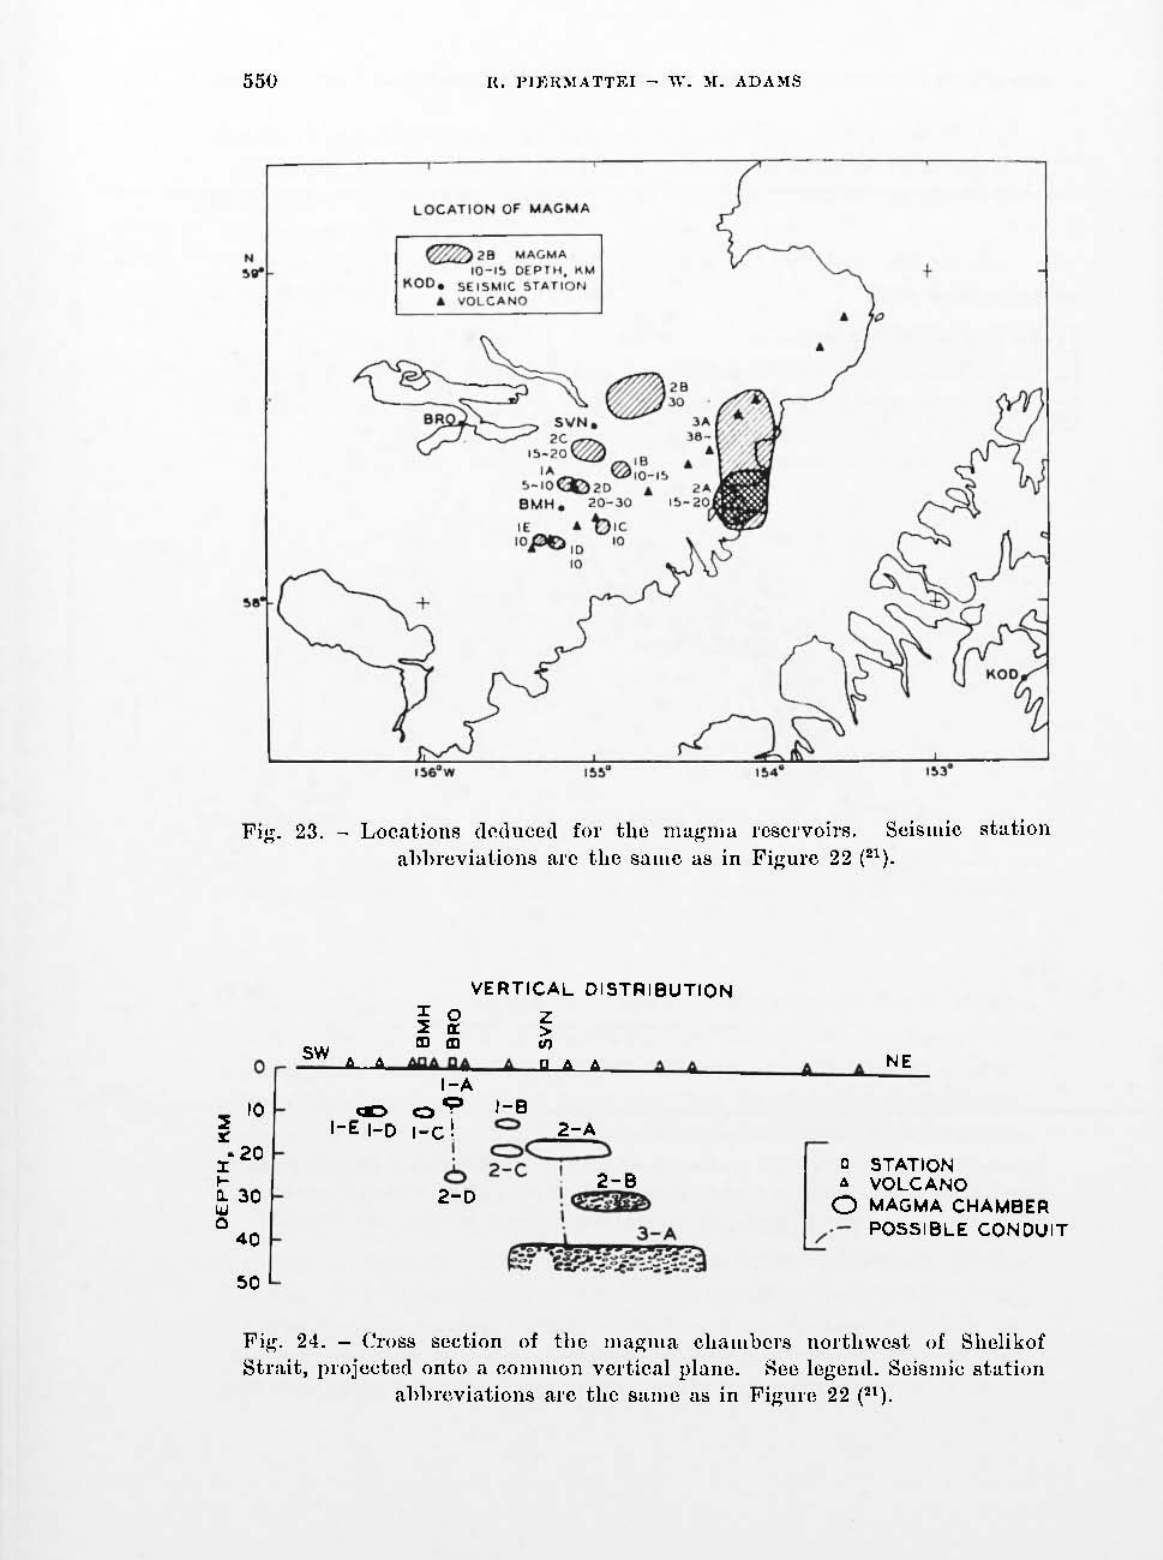
Fig-. 24. - Cross scction (lf thc mugma chulllbcrs lIol'thwcst of Shelikof Stmit, Jll'Ojcded onto a COllllllon vCl'tical plune. Ree legclllL. Seismic statioll ahhnwiations are thc same as in Figure 22